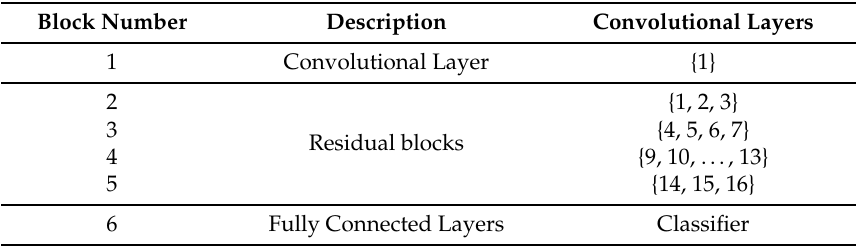
Table 2. ResNet50 network: block structure and convolutional layers grouping.